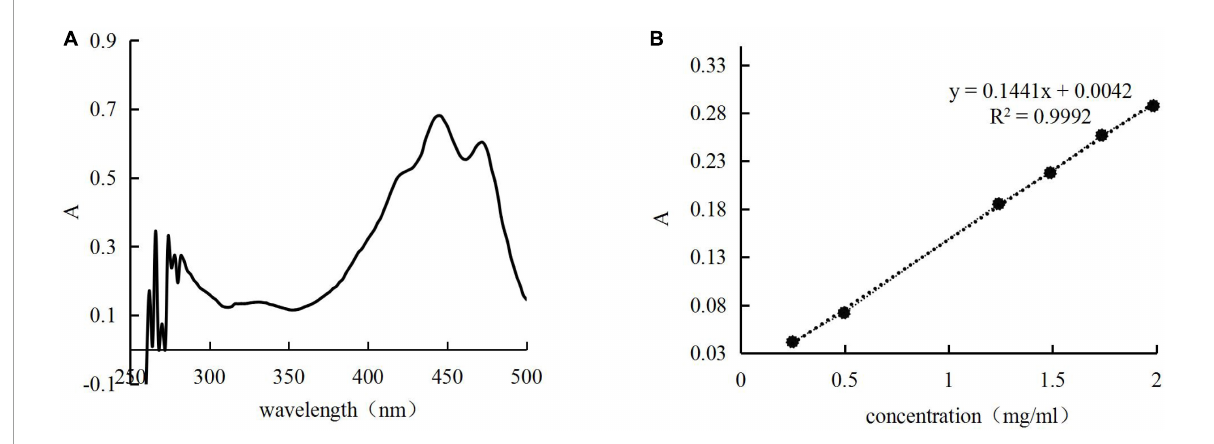
FIGURE1 Full wavelength scan (A) and standard curve (B) for n-hexane solution of Hippophae rhamnoides seed oil.